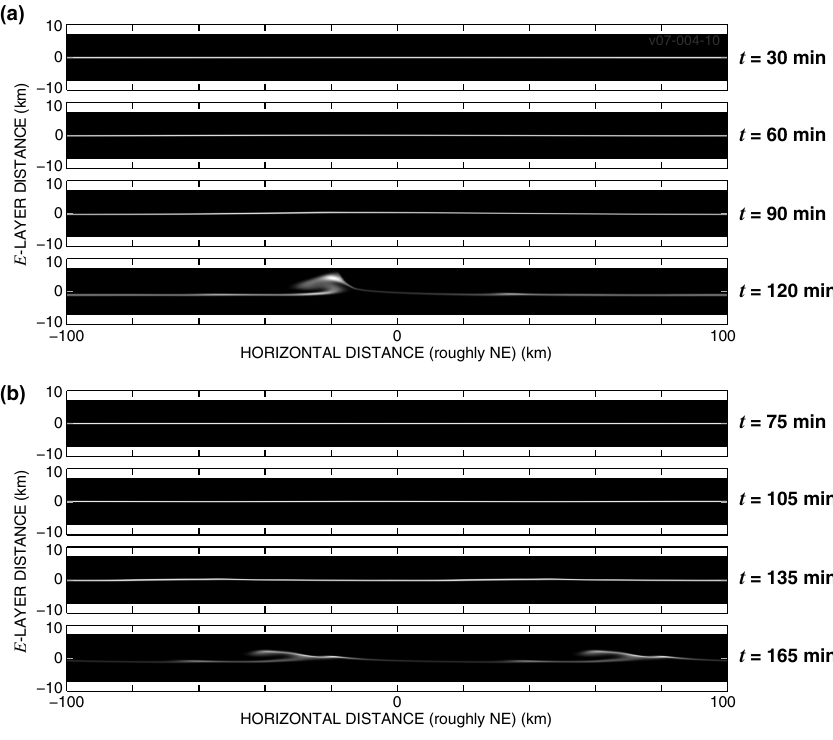
Figure 6: E s layer evolution on a long time scale under the non-resonant condition, for a 200 km wavelength initial seed (a), and for a 100 km wavelength initial seed (b). The boundary conditions are periodic in the horizontal direction. The axes are described in the first paragraph of Section 4, and summarized in Figure 3.